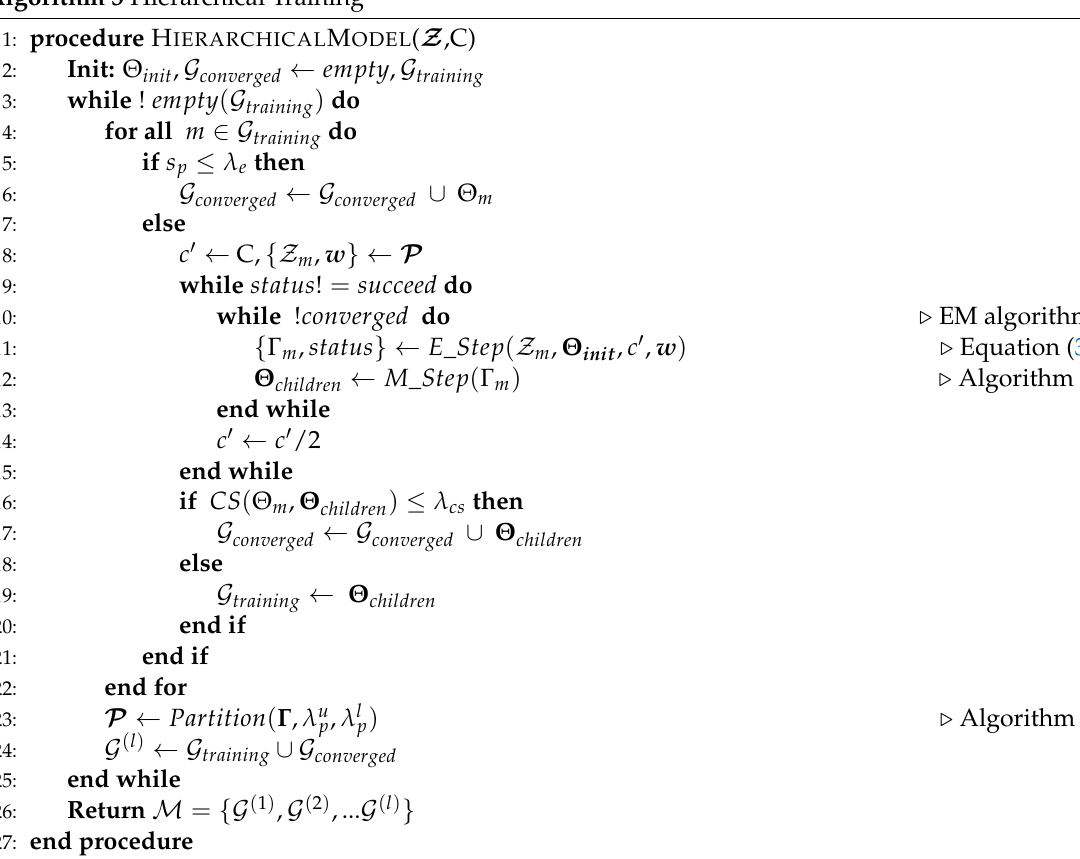
Algorithm 3 Hierarchical Training